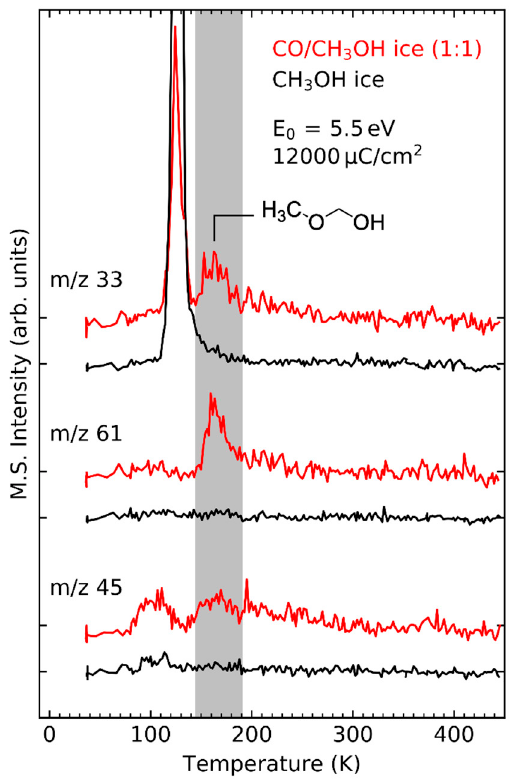
Figure 12. Identification of methoxymethanol by its desorption signal at 161 K (shaded in grey) in the m / z 33, 45, and 61 curves of the TDS after irradiation of CO/CH 3 OH (1:1) mixed ices with 12,000 µ C/cm 2 at 5.5 eV. Notably, methoxymethanol is not observed in pure CH 3 OH. Adapted from Ref. [26] with permission from the PCCP Owner Societies.